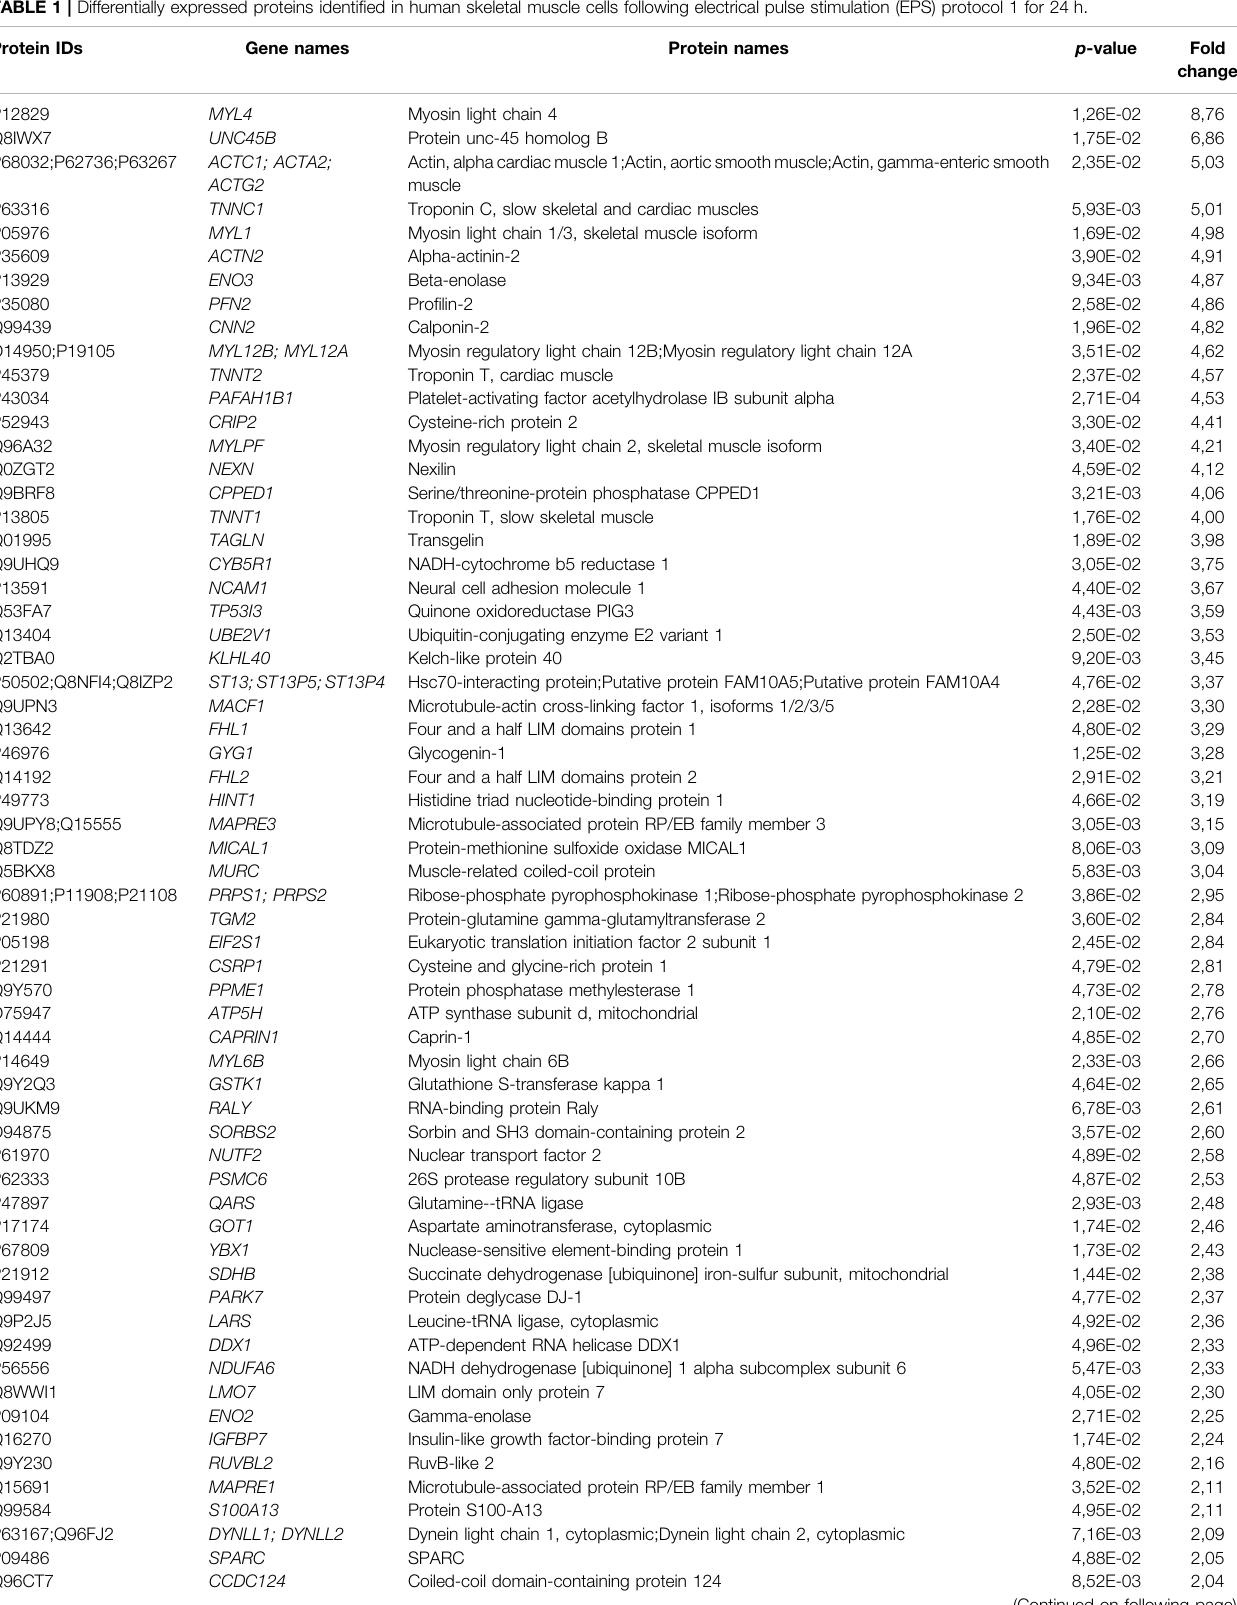
TABLE 1 | Differentially expressed proteins identi fi ed in human skeletal muscle cells following electrical pulse stimulation (EPS) protocol 1 for 24 h. Protein